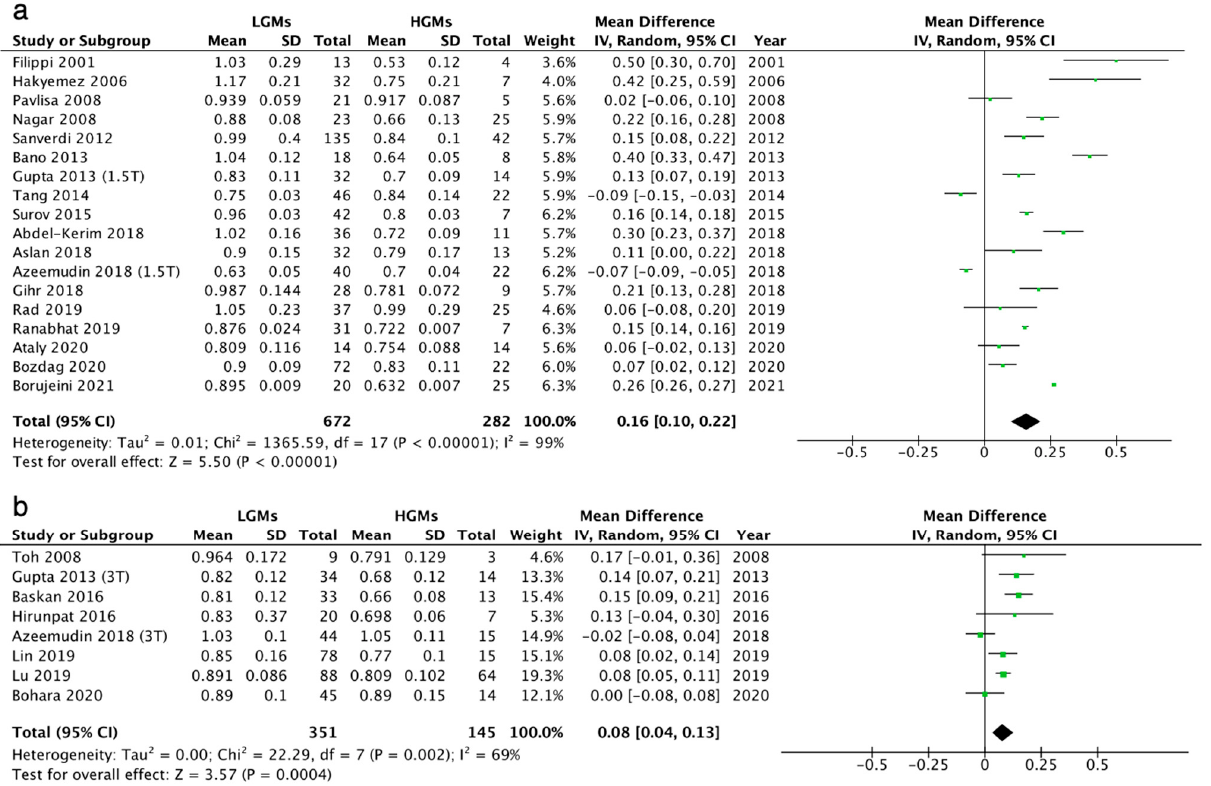
Figure 3. Forest plot for the pooled differences in mean ADC values between LGMs and HGMs in ( a ) 1.5T and ( b ) 3T MRI scanners. The pooled differences were 0.16 and 0.08, respectively ( p < 0.001).